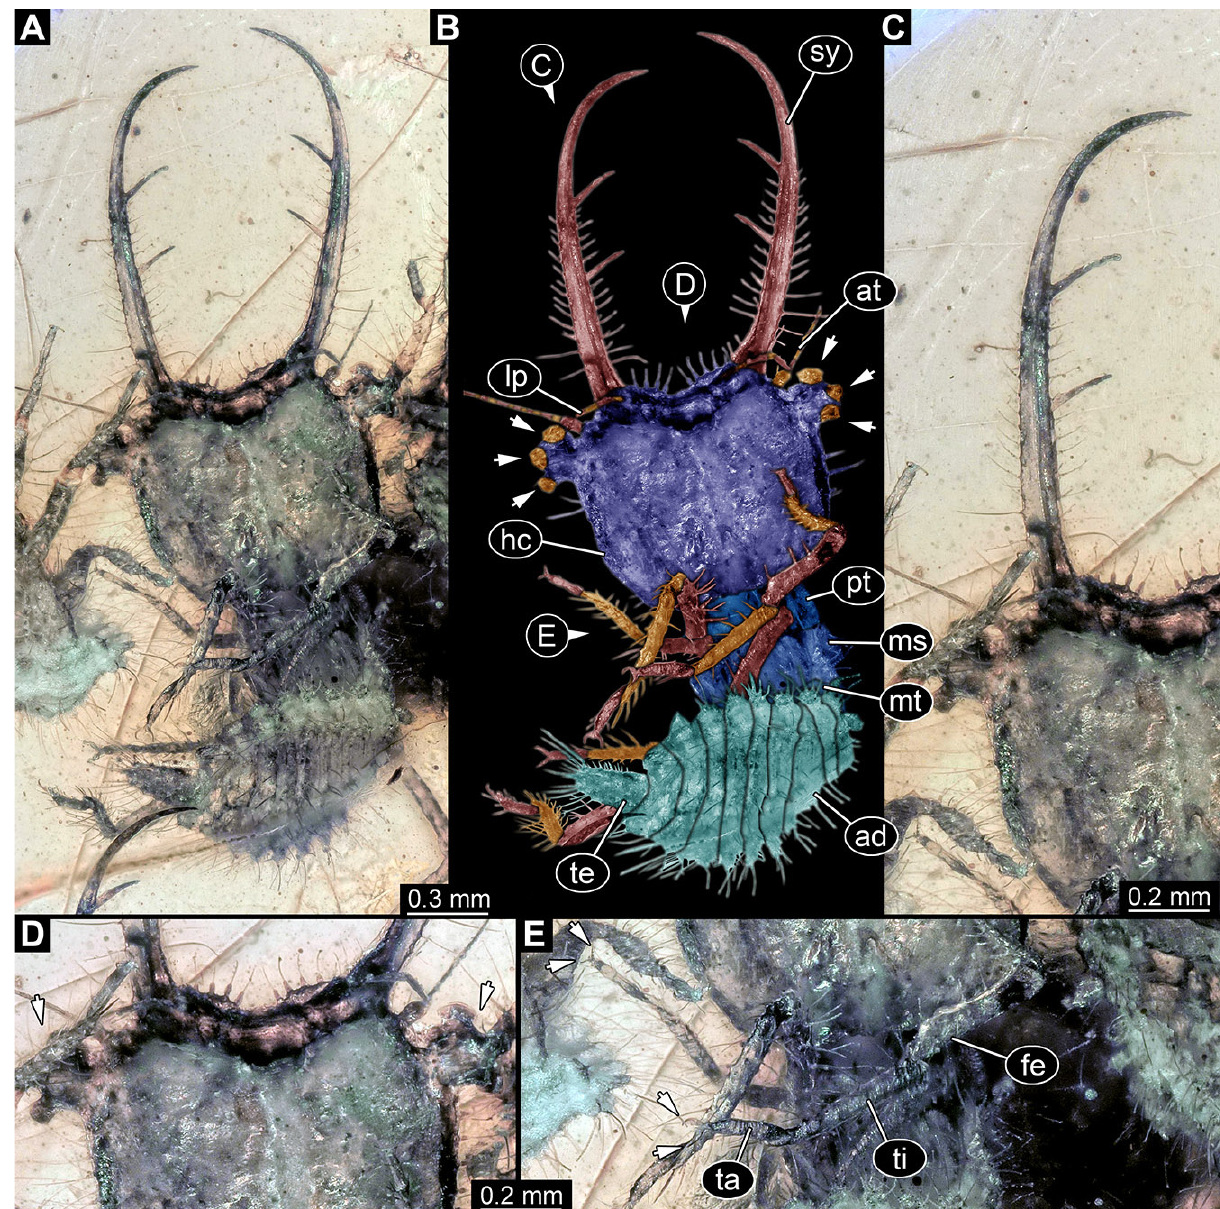
Figure 15. Fossil owllion larva, specimen 3228 (PED 0083b), Cretaceous Kachin amber, Myanmar. ( A ) Overview, ventral. ( B ) Color-marked version of ( A ); arrows point to stemmata. ( C ) Close-up on stylet. ( D ) Close-up on head capsule with fields of stemmata (arrows). ( E ) Close-up on locomotory appendage with claws (arrows). Abbreviations: ad = abdomen; at = antenna; fe = femur; hc = head capsule; lp = labial palp; ms = mesothorax; mt = metathorax; pt = prothorax; sy = stylet; ta = tarsus; te = trunk end; ti = tibia.